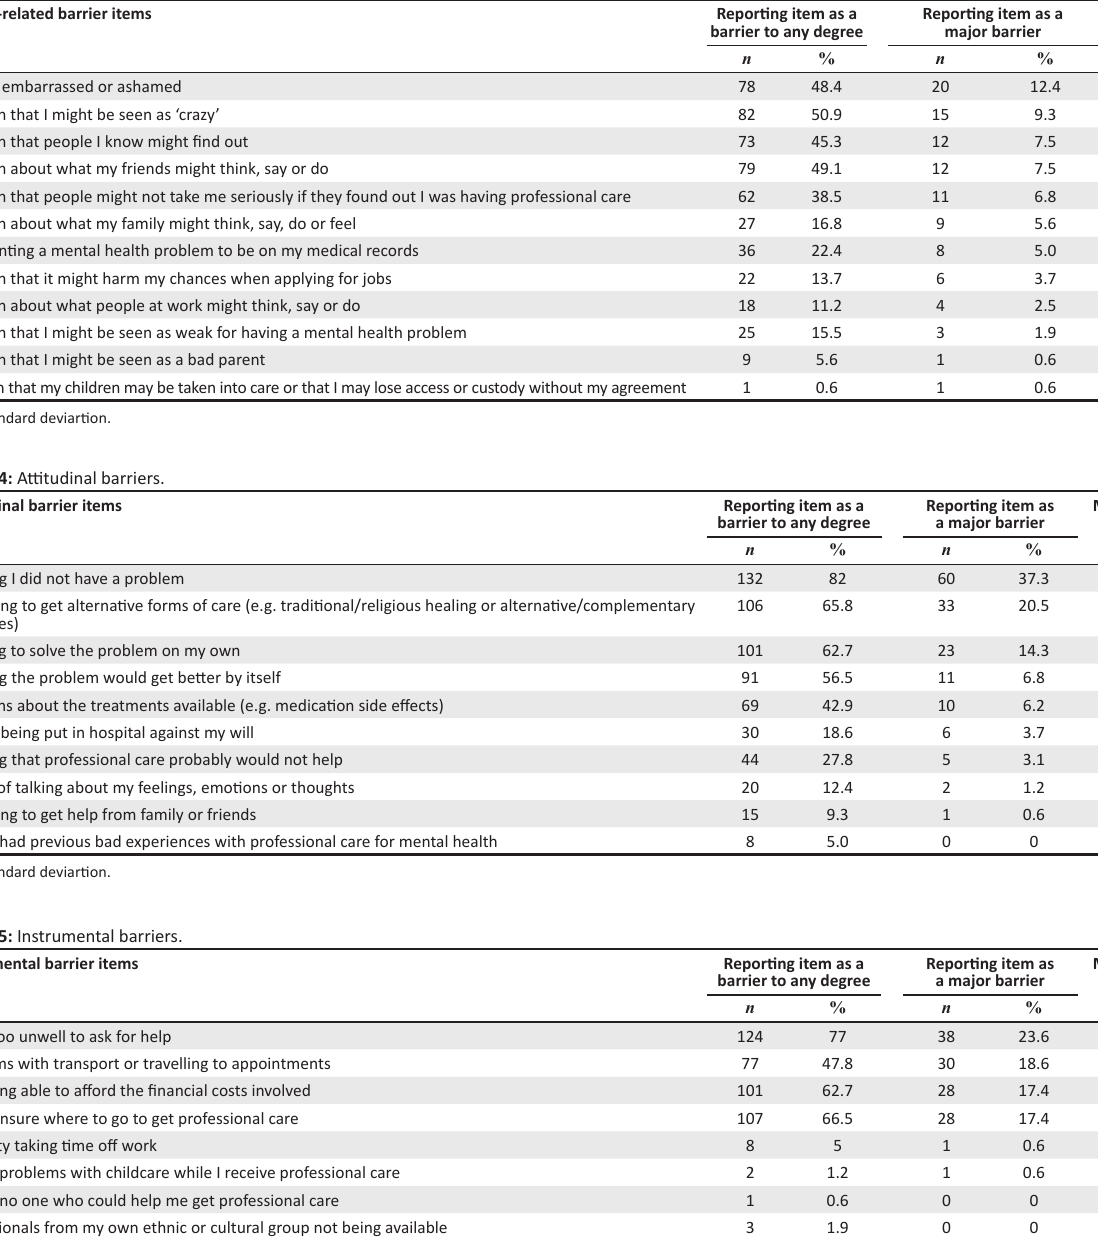
TABLE 3: Stigma-related barriers.